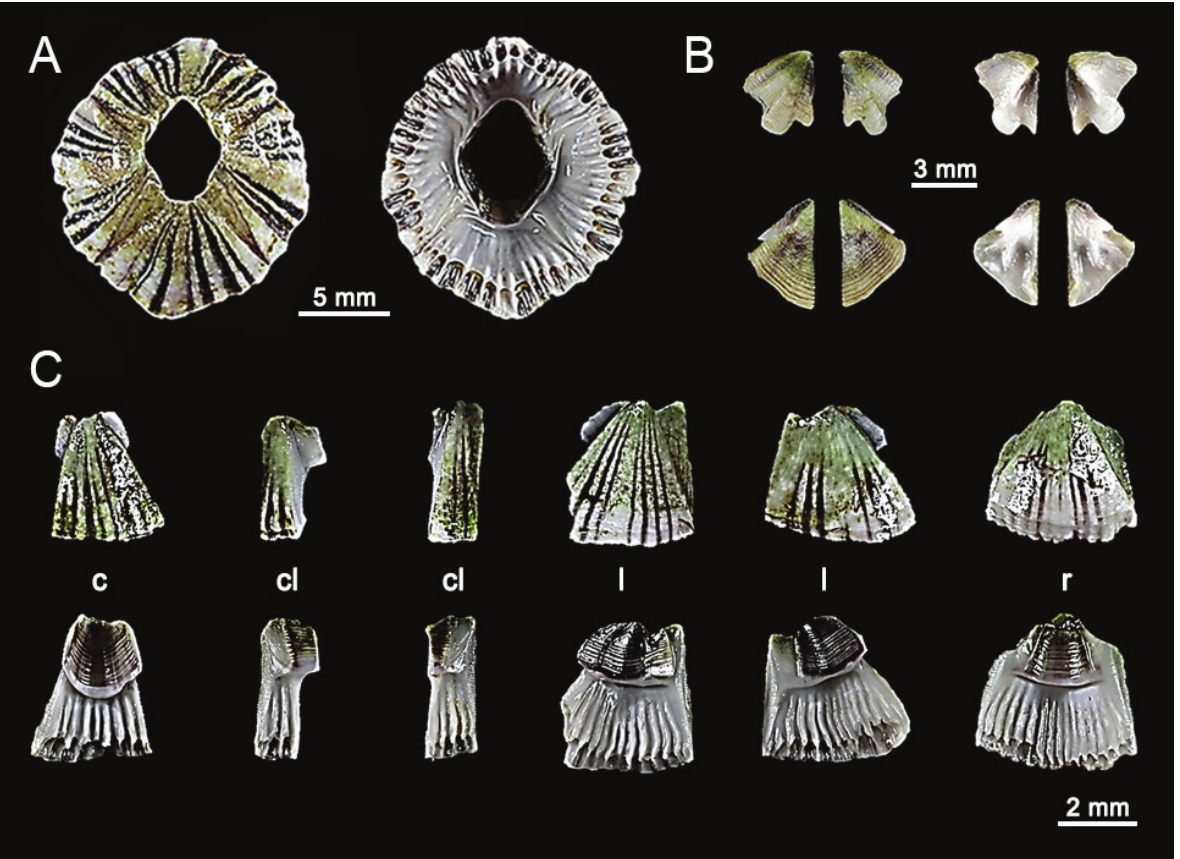
Figure 9. Amphibalanus amphitrite collected from Khao Sam Muk beach, Chon Buri (BUU16.BA.AA30). A. Dorsal and ventral view of external shell, B. External (left panel) and internal (right panel) view of tergum (upper panel) and scutum (lower panel), C. External (upper panel) and internal (lower panel) view of shell plates. Abbreviations: c, carina; cl, carinal latus; l, latus; r,